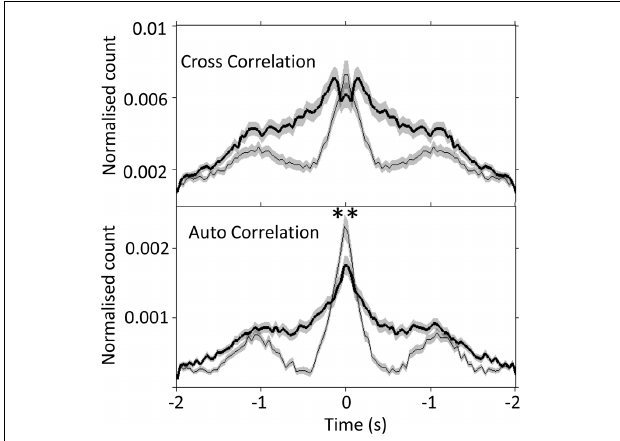
FIGURE 4 | Slow-wave modulation of PrL activity is disrupted by FN stimulation in urethane anesthetized rats. Cross- and auto-correlogram plots (40ms bins, calculated over 2s pre/post-stimulation) of all possible PrL cell pair combinations ( n = 69 cells, 8 rats) during non-stimulated (thin line) and FN stimulation (thick black line) states in urethane anesthetized rats. ∗∗ P < 0 . 01, paired t -test. Note attenuation of slow-wave periodicity during FN stimulation also reported in anesthetized cat (Steriade, 1995).